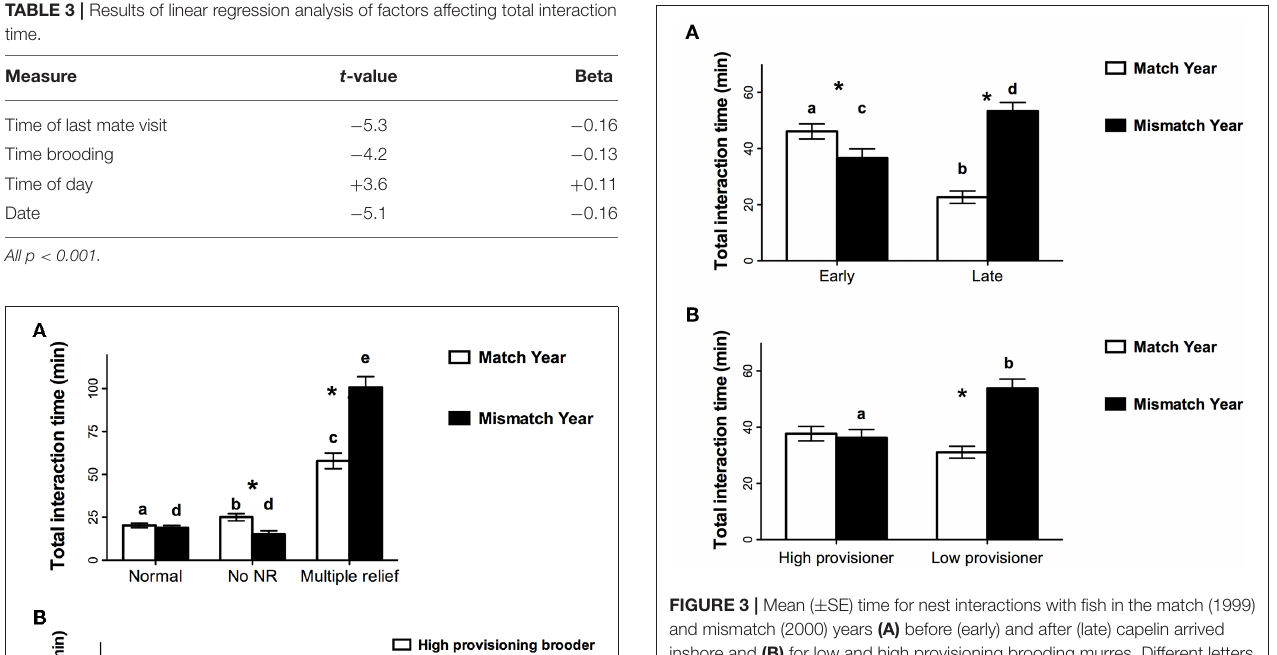
compared to late in mismatch year [ t (432) = 4.57, p < 0.001]